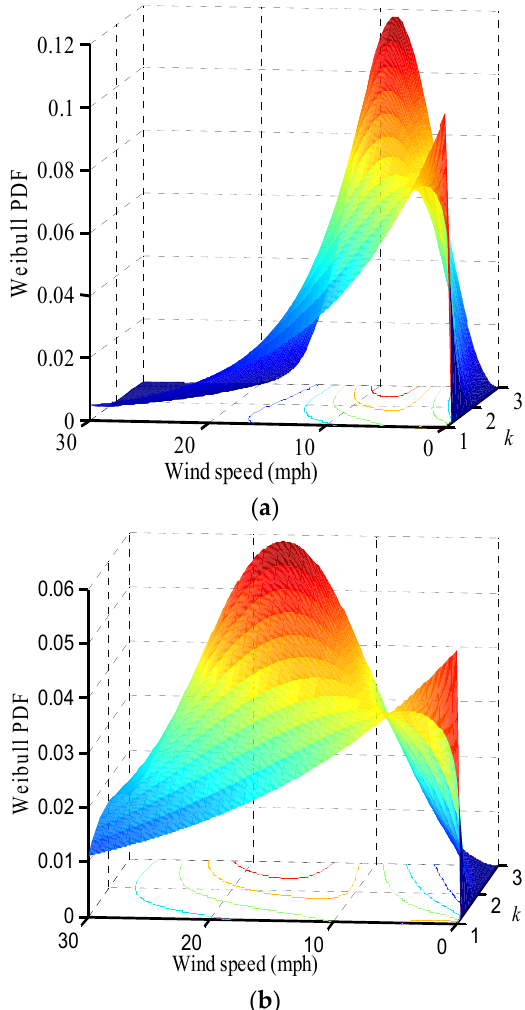
Figure 7. Three-dimensional Weibull PDF vs. wind speed and scale factor (1 mph = 0.446 m/s). ( a ) k = 1; ( b ) k = 2.